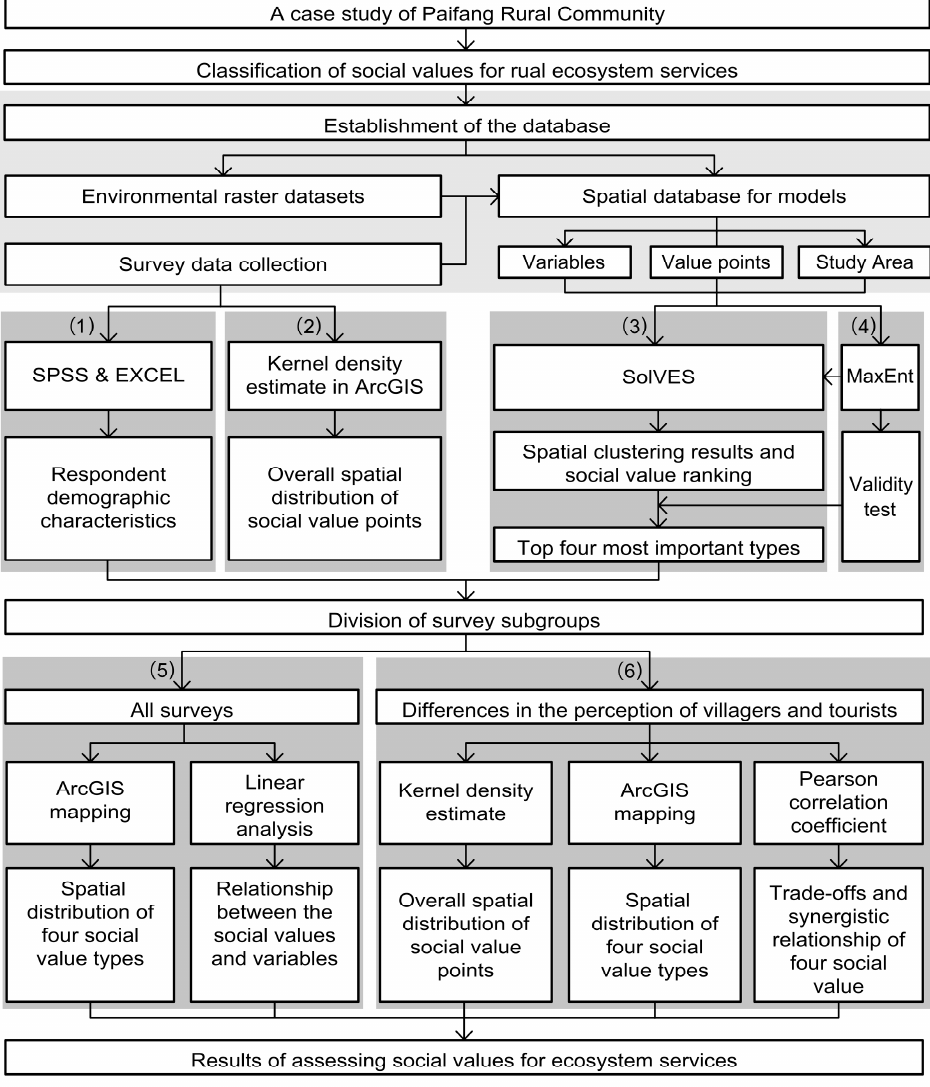
Figure 1. The research framework of assessing social values for rural ecosystem